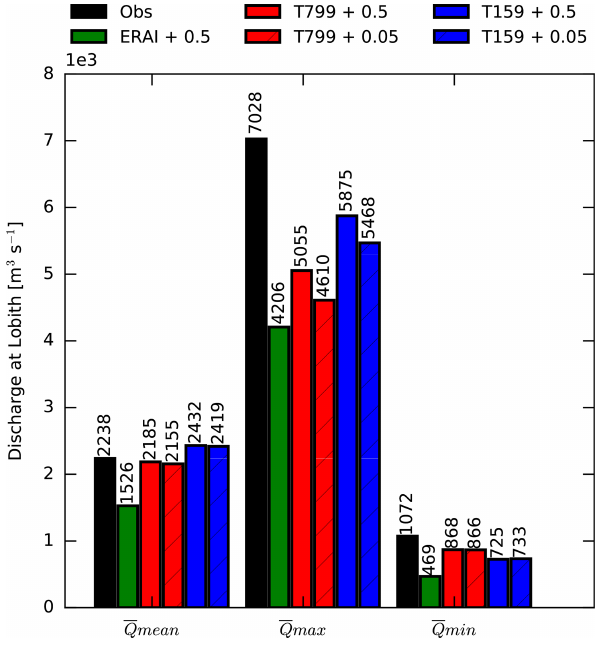
Figure 7. Q mean , Q max , and Q min in m 3 s − 1 at Lobith for the ob- servations and the different combinations of